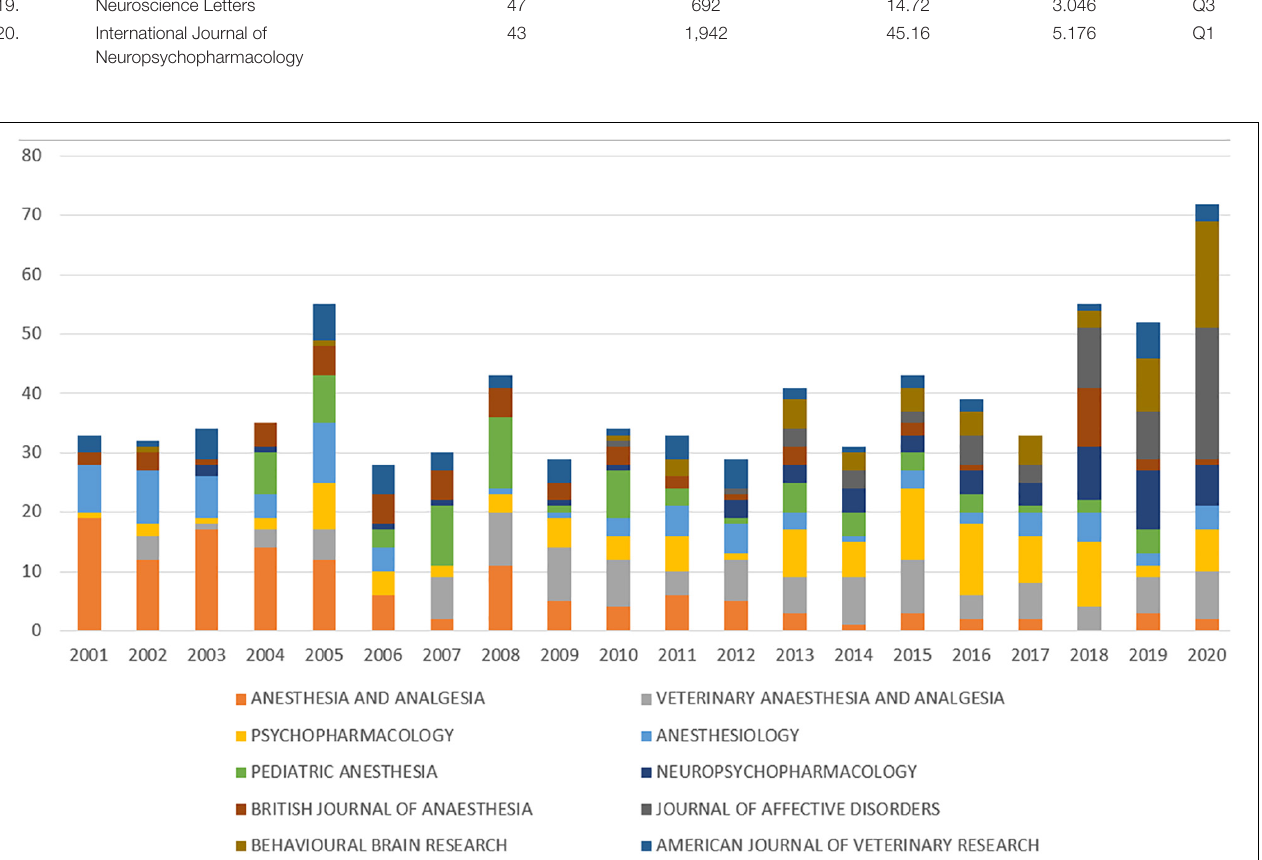
FIGURE 4 | The number of articles published in different journals each year.